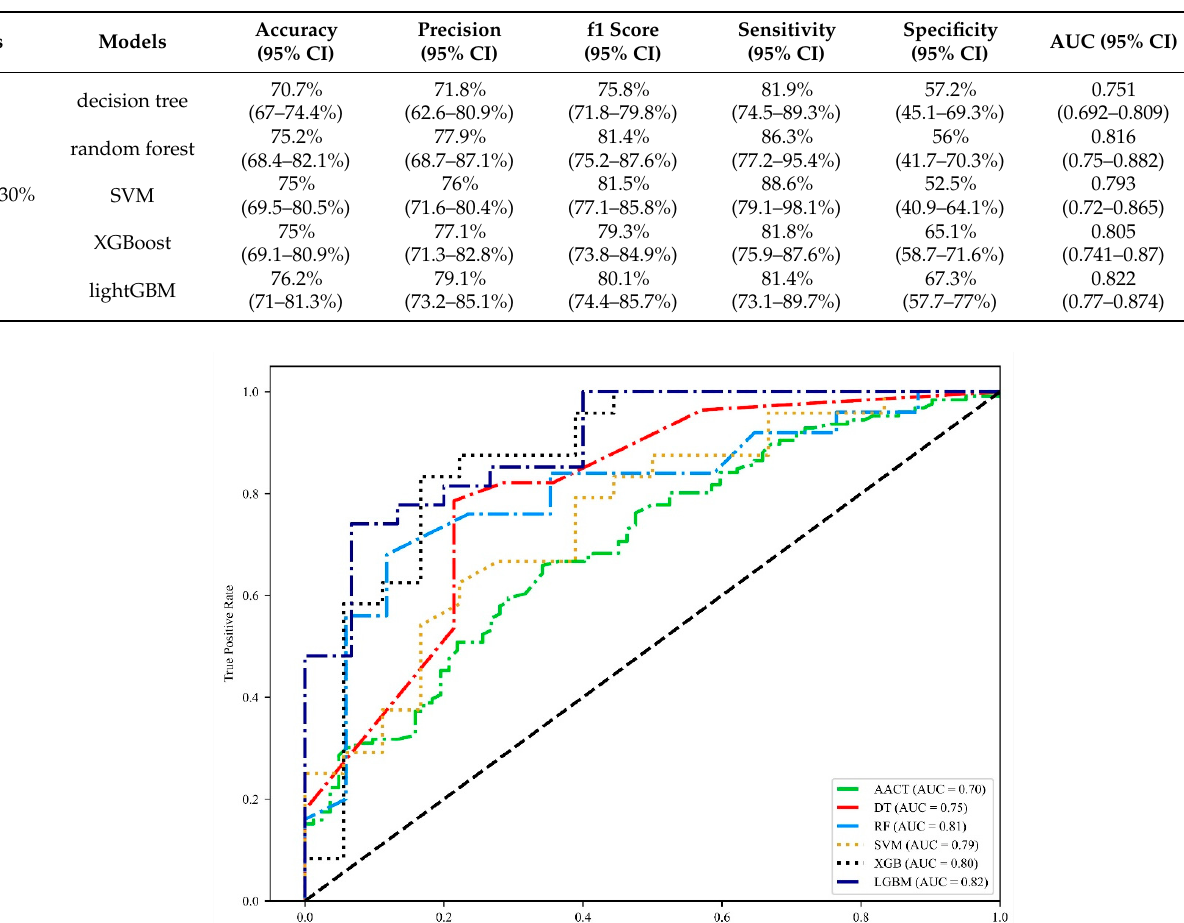
Table 5. Predictive performance of five models in discriminating CAD patients with stenosis rates < 30% and >30%.